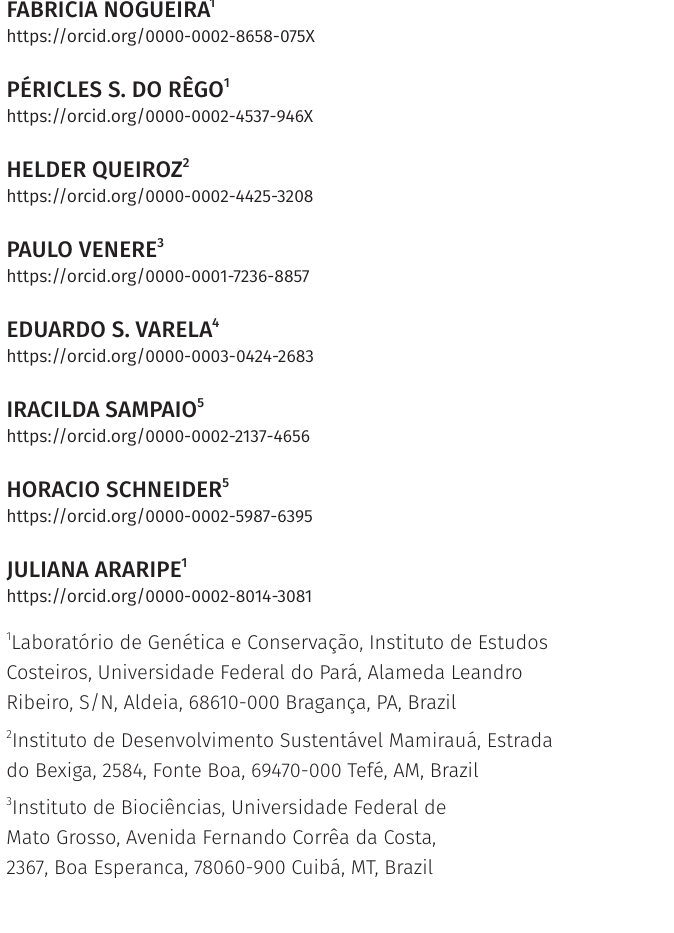
Figure S2. Population structure in Arapaima based on a Bayesian analysis , without an a priori definition of the stocks. MM-Mamirauá, ST-Santarém and